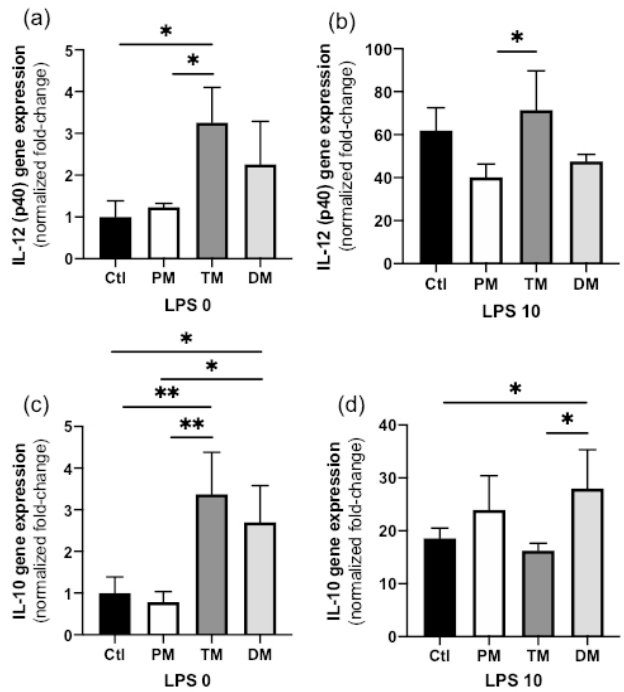
Figure 2. ( a , b ) Interleukin-12 (IL-12) (p40) and ( c , d ) interleukin-10 (IL-10) gene expression by human macrophage-like cells derived from the monocytic cell line THP-1 treated with pooled milk from preterm-delivering mothers (PM), term-delivering mothers (TM), pasteurized donor milk (DM) or in absence of milk (Ctl). Macrophages were incubated with the treatments at 50 µ g total proteins / mL or no treatment (media) for 1 h and then incubated ( a , c ) at steady state (LPS 0 ng / mL) for 3 h or ( b , d ) activated with low-dose lipopolysaccharides (LPS) (10 ng / mL, low inflammatory state) for 3 h. Values are mean ± SD of three independent experiments and three replicates in each experiment. Fold-changes for each gene were normalized to GAPDH and are relative to the gene expression in untreated cells (without LPS or milk). Asterisks show statistically significant di ff erences between groups (** p < 0.01; * p < 0.05) using one-way ANOVA followed by Tukey’s multiple comparisons tests.